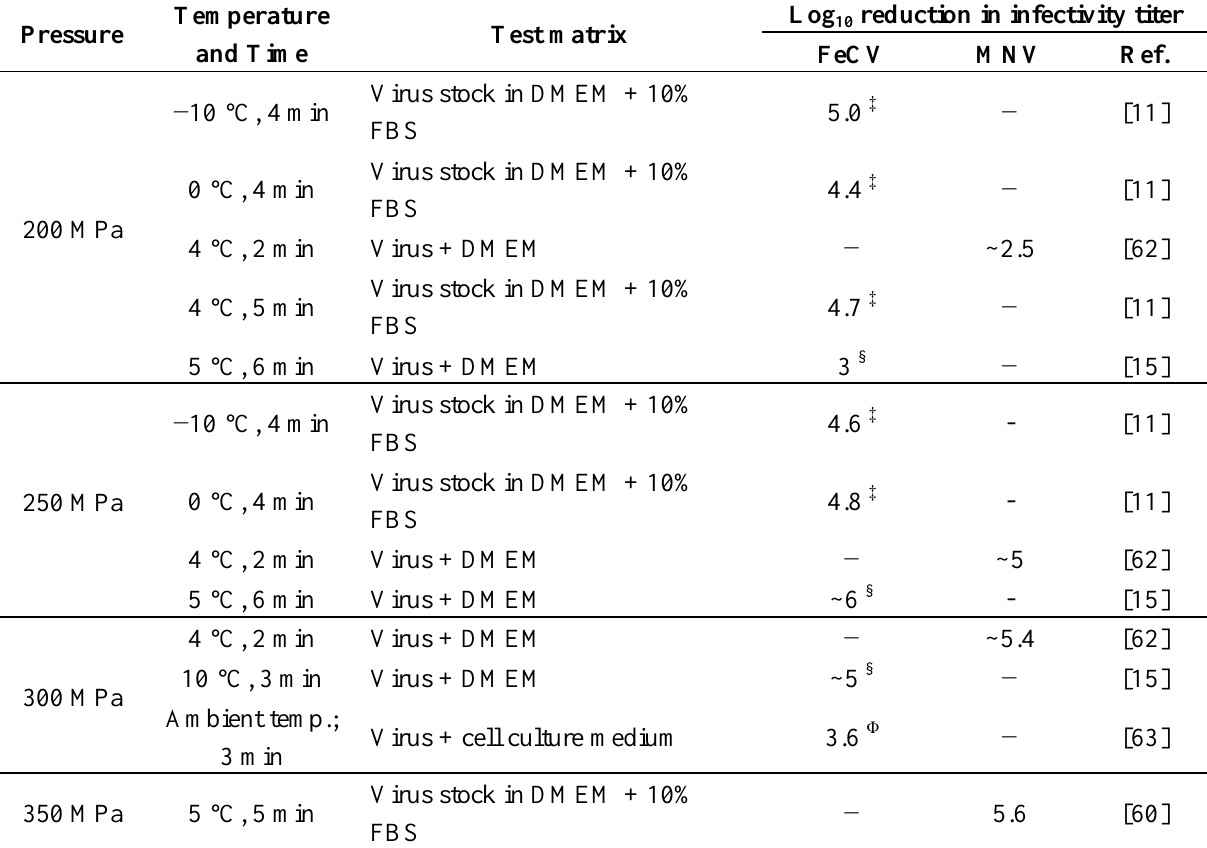
Table 5. Inactivation of caliciviruses by high-pressure